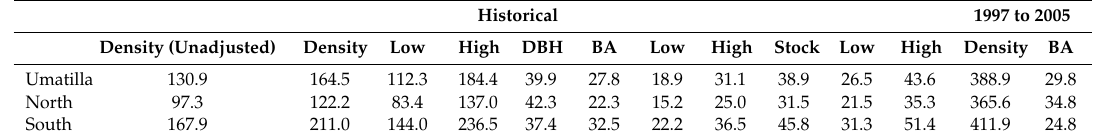
Table 4. Structure (density in trees / ha unadjusted and adjusted for bias; DBH—diameter in cm; BA—basal area in m 2 / ha; stock—percent stocking) from historical surveys and current structure (density in trees / ha, BA = basal area in m 2 / ha) from 1997 to 2005 surveys for all of the Umatilla National Forest and north and south units.